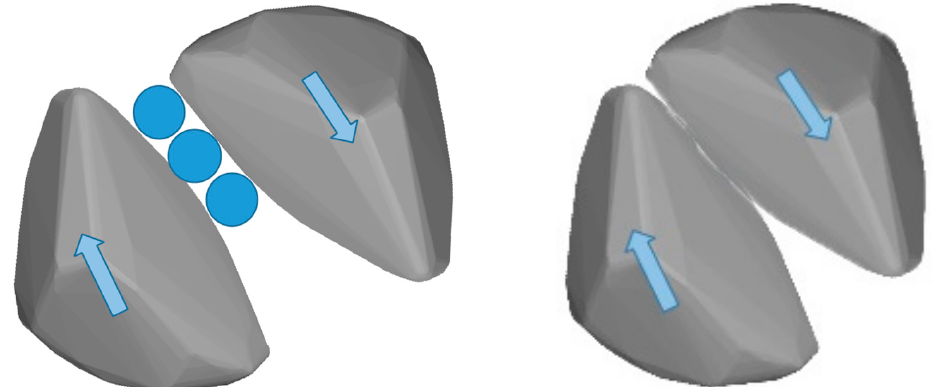
Figure 18. Illustration of rolling and relative sliding interactions between particles causing loss of contact.